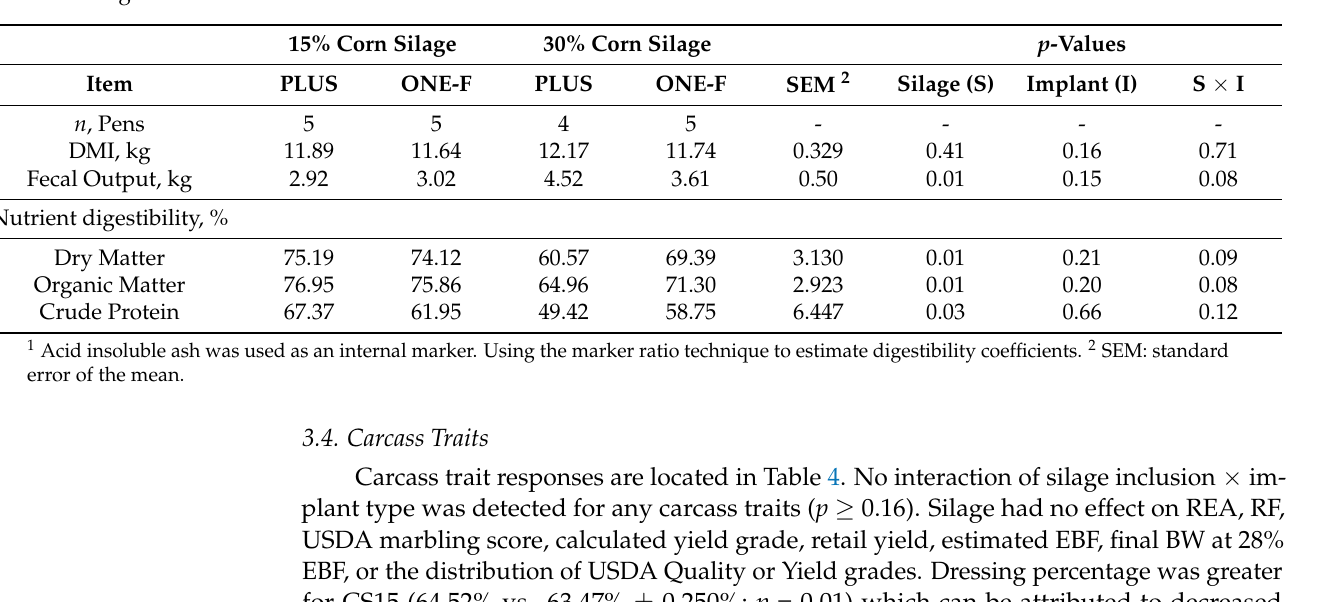
Table 3. Digestibility of dry matter, organic matter, and crude protein in finishing diets containing 15% or 30% (DM basis) corn silage and administration of a non-coated (PLUS) or coated (ONE-F) implant containing 200 mg of trenbolone acetate and 28 mg of estradiol benzoate 1 .